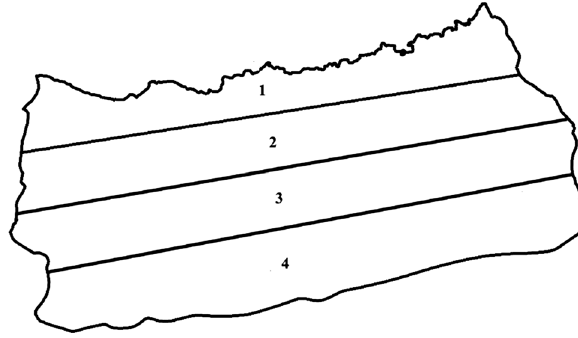
Fig. 2 Aquifer-wide zoning in Bandar-e-Gaz